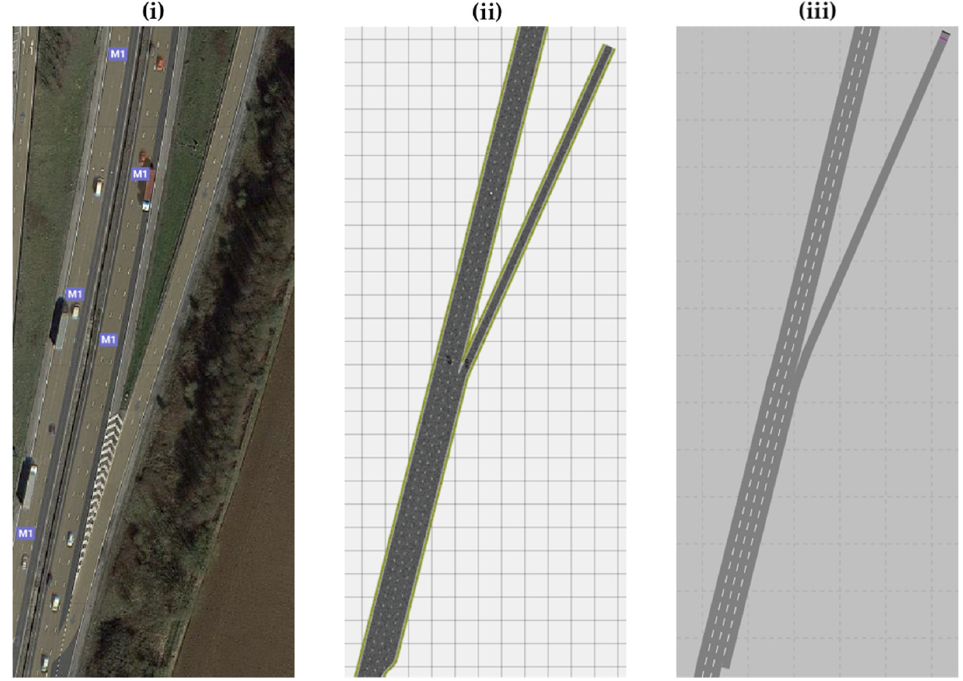
Figure 6. Section of the motorway for the demonstration experiment showing ( i ) actual representa- tion and virtual reconstruction in ( ii ) PreScan and in ( iii ) PTV VISSIM. and virtual reconstruction in ( ii ) PreScan and in ( iii ) PTV